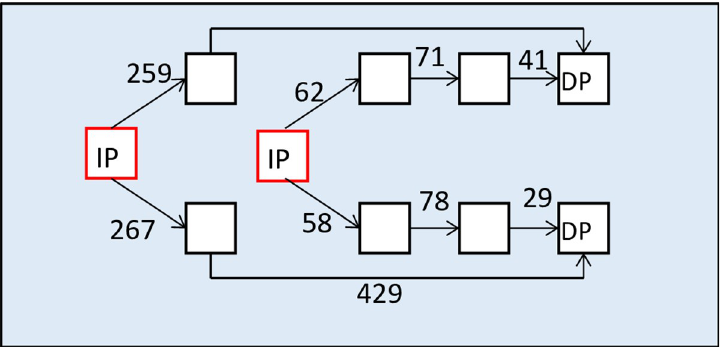
Fig 2. An example of a graph showing the coding of escape routes for a passenger ship. IP-initial points, DP- destination points.